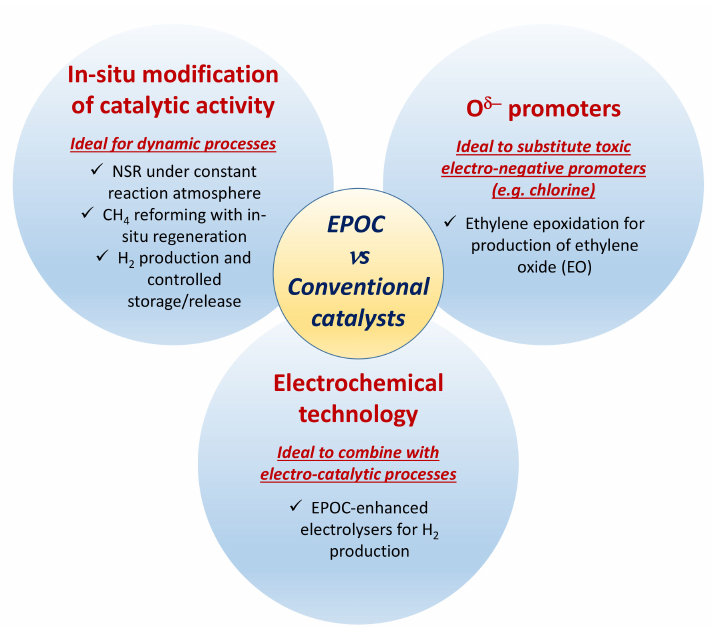
Figure 1. Suggested EPOC applications with unique benefits compared to conventional catalytic